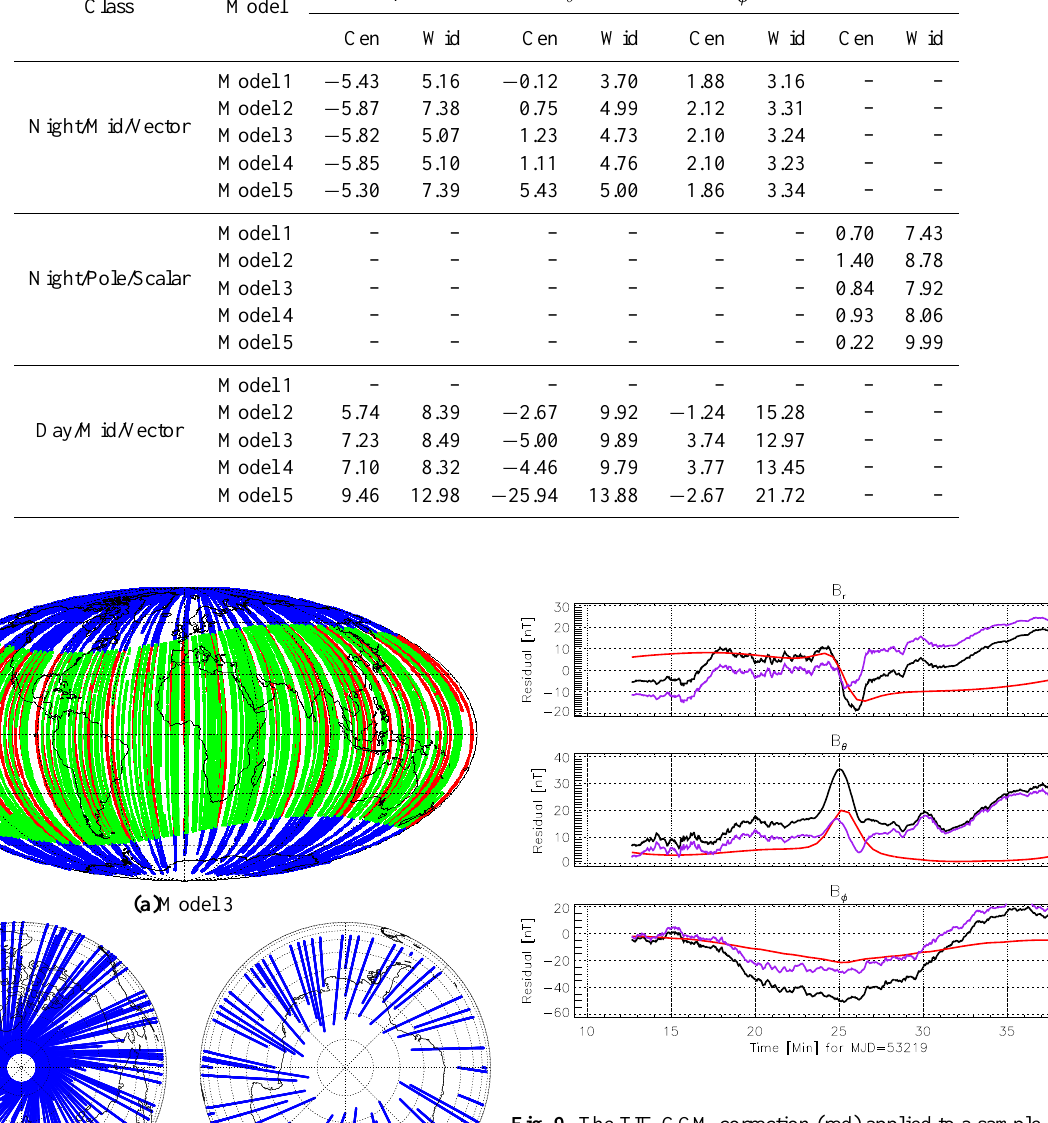
Fig. 9. The TIE-GCM correction (red) applied to a sample orbit of the dayside data in Model 3 for B r (top), B θ (middle) and B φ (bot- tom) components in nT vs. time [min]. The residual (black) of the dayside data was computed relative to the CHAOS model (residuals used to facilitate clarity). The difference of the data residual and the TIE-GCM correction is characterized by the purple curve and represents the data used as input to Model 3 (minus the CHAOS residual computation). While the TIE-GCM correction mirrors the data in a general sense, it can also adversely affect the corrected data by amplifying the misfit in some area (especially the higher latitude